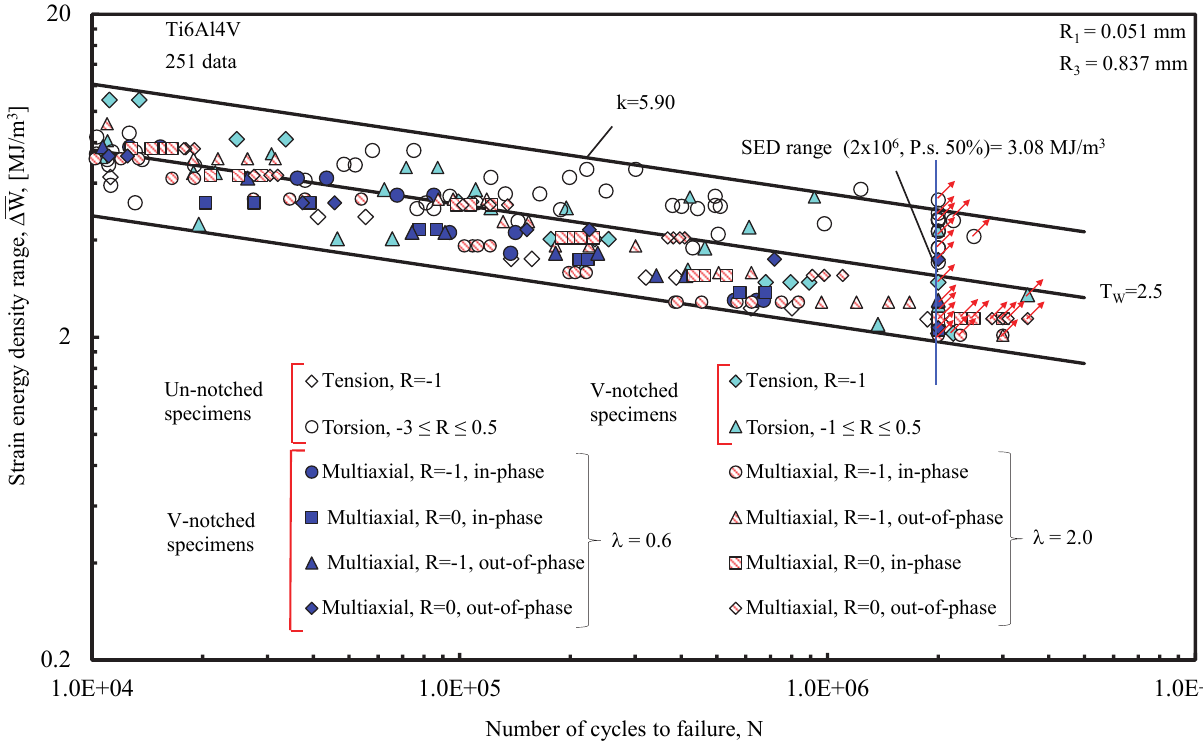
Figure 5: Local SED-based synthesis of experimental fatigue results relevant to smooth and sharply notched specimens. Almost 250 fatigue data are summarised in the scatter